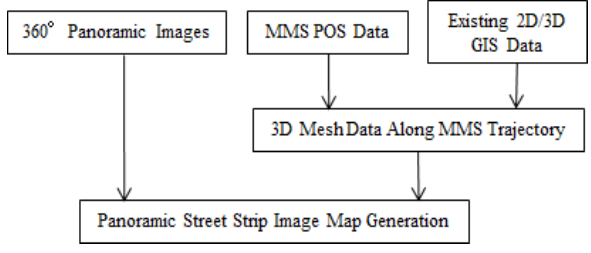
Figure 2. Flow diagrams of Pano-Street